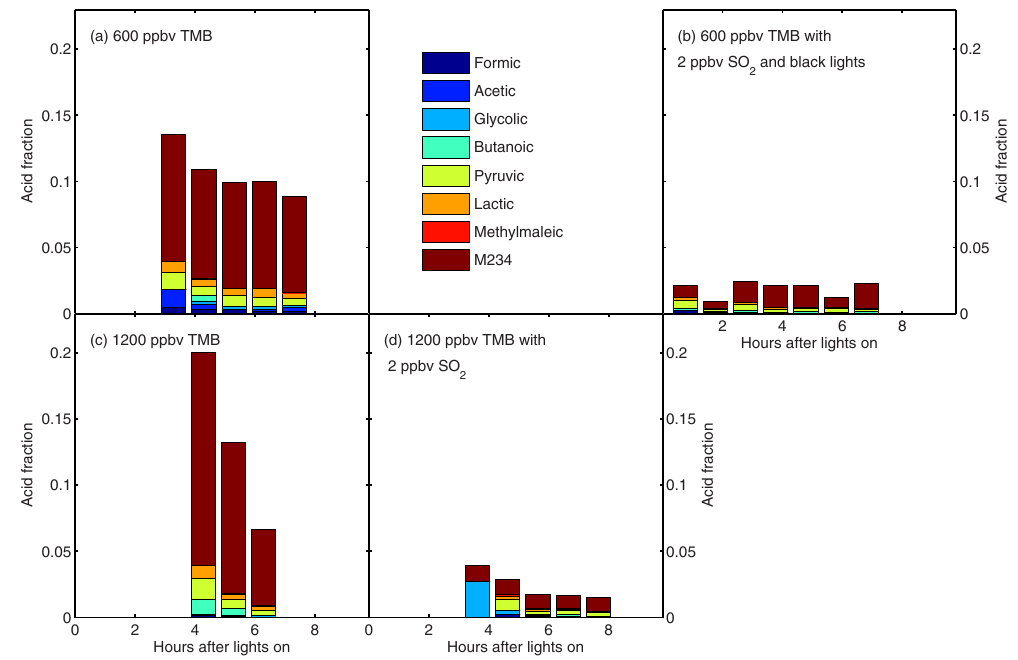
Figure 8. Stacked aerosol concentrations of the main detected organic acids normalised to the aerosol mass concentration (from SMPS) for the different experimental